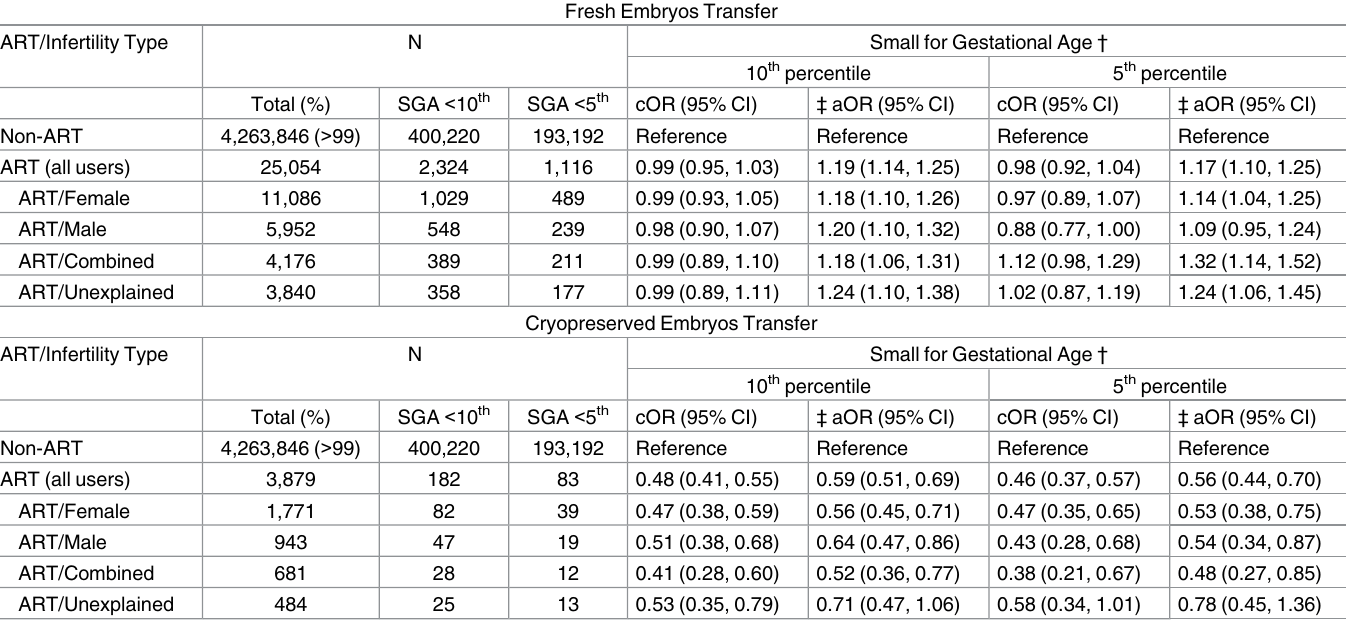
Table 2. Associations between newborn size and ART singletons born following fresh or cryopreserved embryos transfer, using non-ART as the referent group. Population-based data of all singletonlive births in Florida and Massachusetts 2000–2010 and in